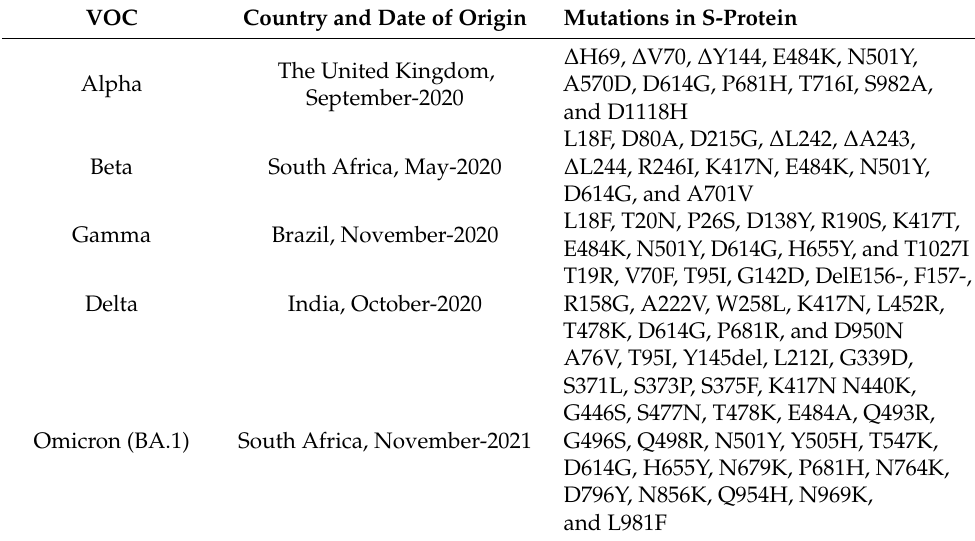
Table 1. Variants of concern (VOCs), country and date of origin, and mutations in S-protein. VOC Country and Date of Origin Mutations in